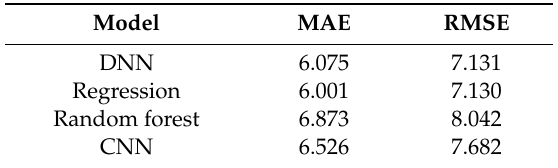
Table 2. The results of the four models using the basic method.